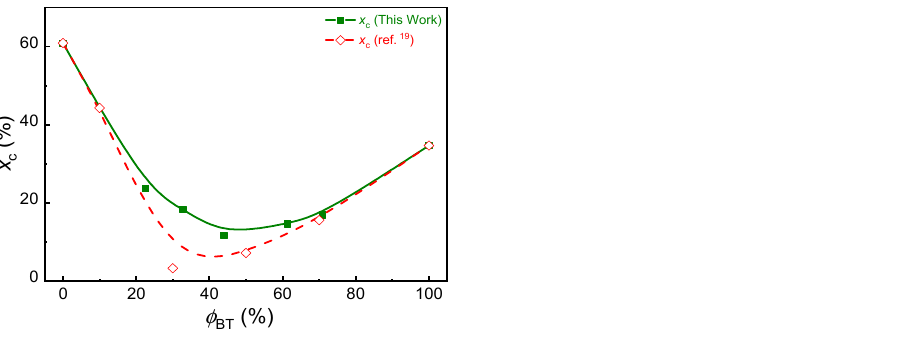
Figure 3. Crystallinity ( x c ) of different PBST ( ϕ BT = 0–100 mol%) films (the data of open points from ref. [19]).